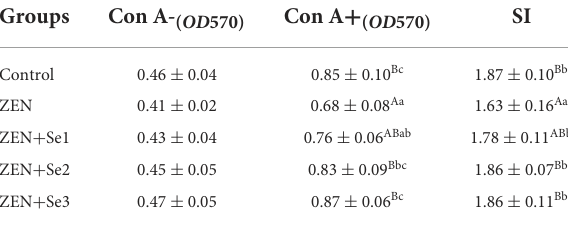
TABLE 2 Effects of SC on Con A-induced splenocyte proliferation induced by ZEN in mice *